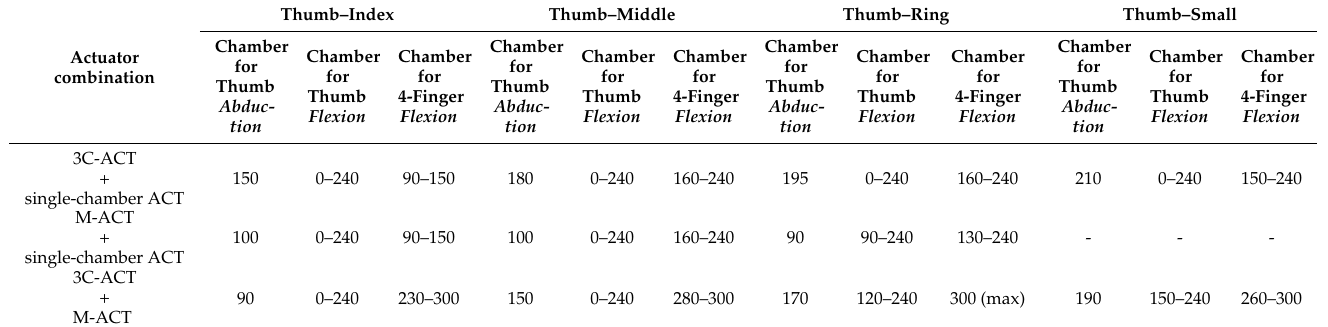
Table A1. The air pressure range of actuators during thumb to finger pinching (kPa).